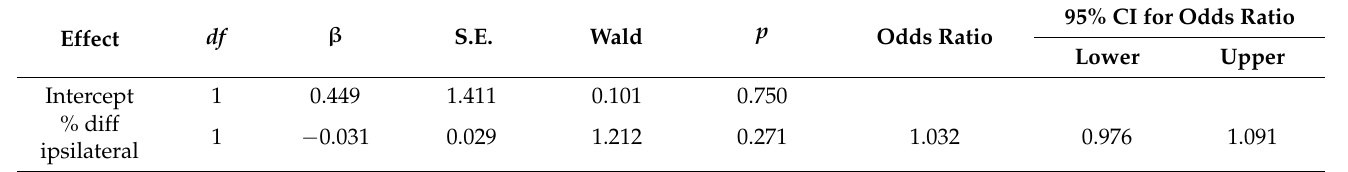
Table 6. Logistic regression model results with ipsilateral imbalances as a